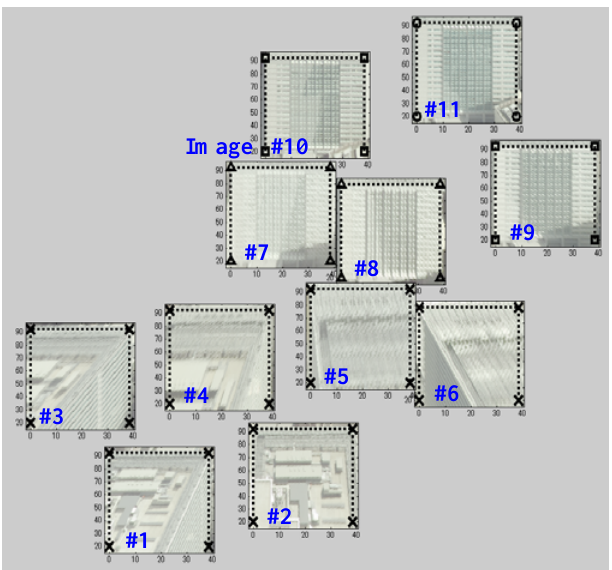
Figure 7. Interpolation in Local